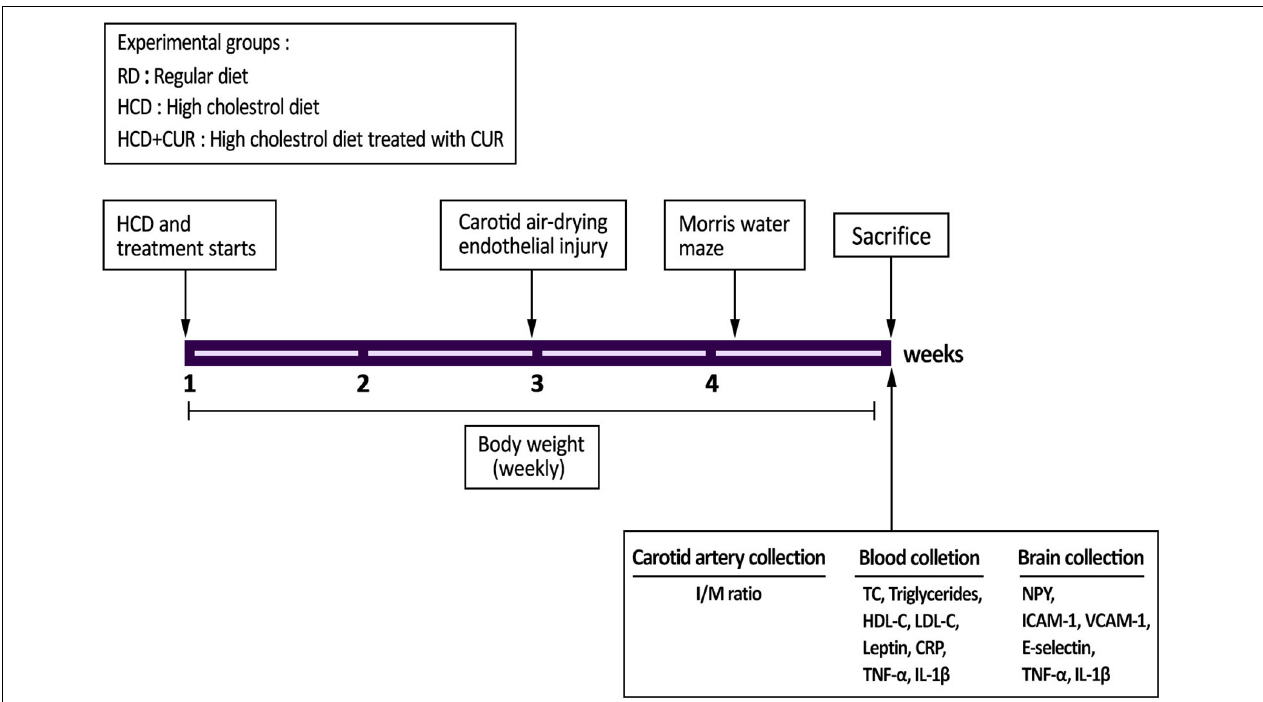
FIGURE 1 | Experimental outline. SD rats were divided into three experimental groups ( n = 20/each): control group fed a regular diet and vehicle (1% carboxymethyl cellulose sodium, CMC) (RD); group fed a high-cholesterol diet and 1% CMC by gavage (HCD); and group fed a HCD and a daily dose of 200 mg/kg body weight curcumin by gavage (HCD + CUR) for 4 weeks. At the end of the second week, carotid endothelial injury was performed by using the air-drying endothelial denudation method for these three groups. Body weight was monitored throughout the 4-week study period. The Morris water maze was carried out 5 days before sacrifice as indicated in the figure. After sacrifice, biological samples were used for assessments of biochemical, histological, neuroendocrine, and immune-related